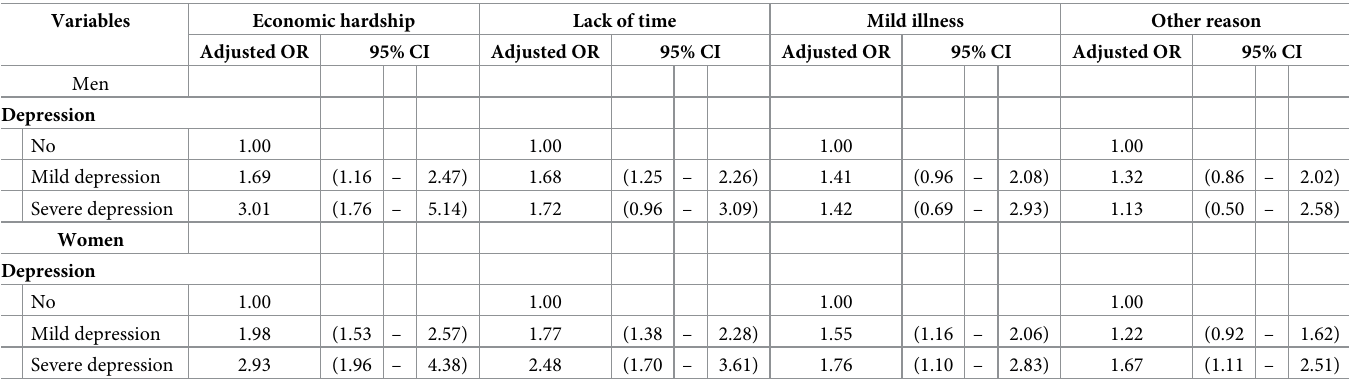
Table 4. Factors associated with the reason for unmet healthcare needs a .